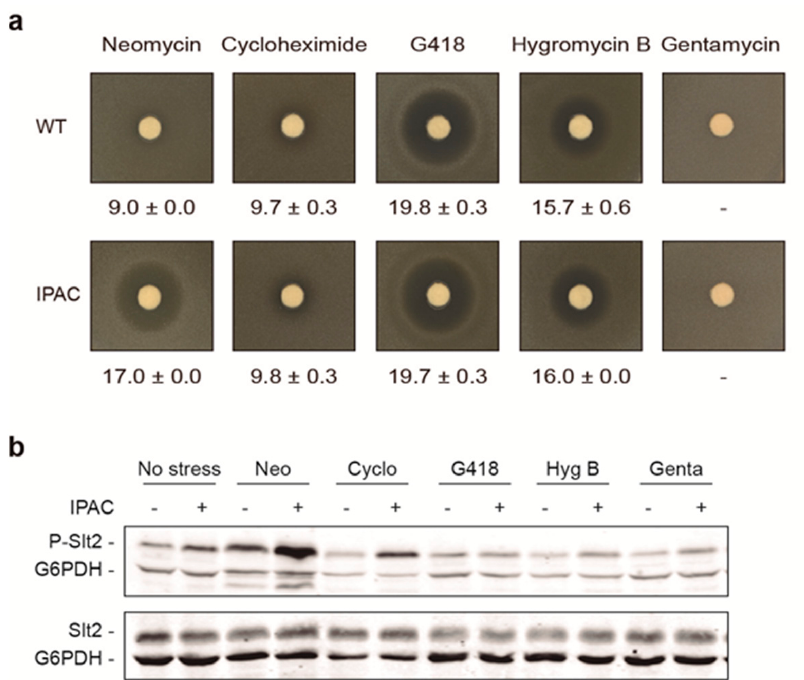
Figure 3. Neomycin is the only protein synthesis inhibitor that activates the CWI pathway. ( a ) Halo sensitivity assay of vector (WT) or Y3656 strains with integrated IPAC. Disks were impregnated with 100 mg/mL of neomycin sulfate, 1 mg/mL of cycloheximide, 50 mg/mL of G418, 50 mg/mL of hygromycin B, or 50 mg/mL of gentamycin. Mean and standard deviations of halo diameters from three different experiments are shown. ( b ) Western blotting analysis of extracts from Y3656 strain without ( − ) or with IPAC (+) and treated or not (no stress) for 4 h with 10 mg/mL neomycin, 25 µ g/mL cycloheximide, 31.3 µ g/mL G418, 62.5 µ g/mL hygromycin B, or 10 mg/mL gentamycin sulfate. Dually phosphorylated Slt2, total Slt2 protein, and G6PDH (as a loading control) were detected with anti-phospho-p44/42, anti-Slt2, and anti-G6PDH antibodies, respectively. A representative blot from three independent experiments is